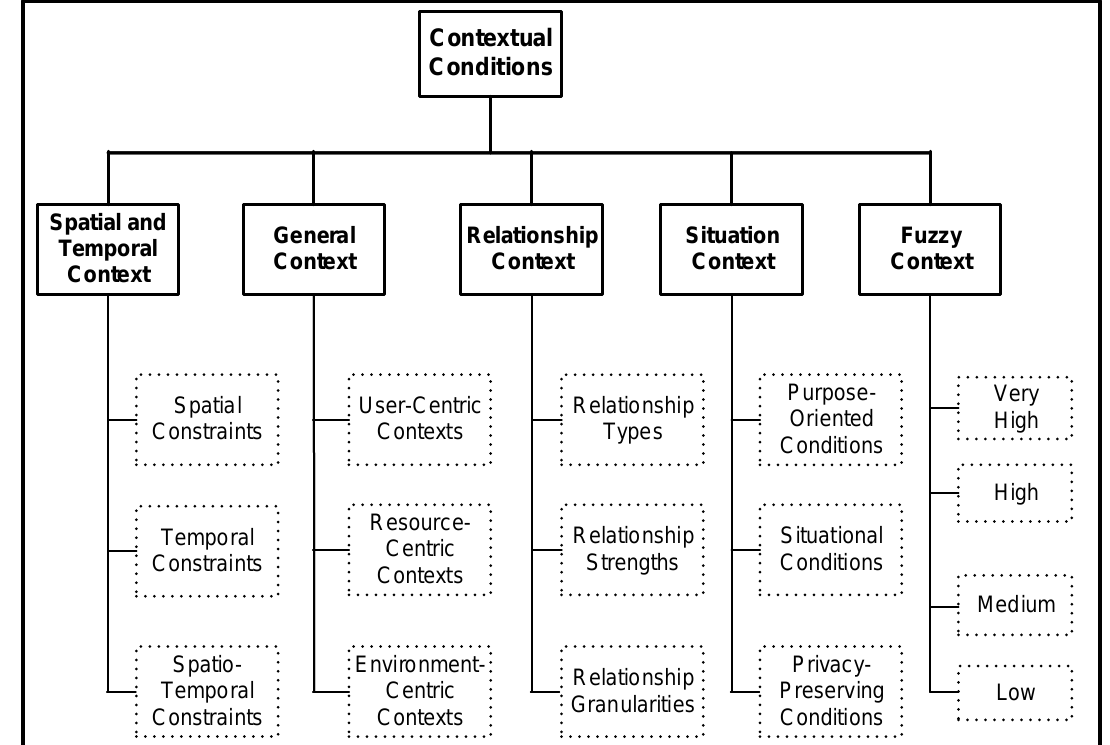
Figure 2. A taxonomy of contextual